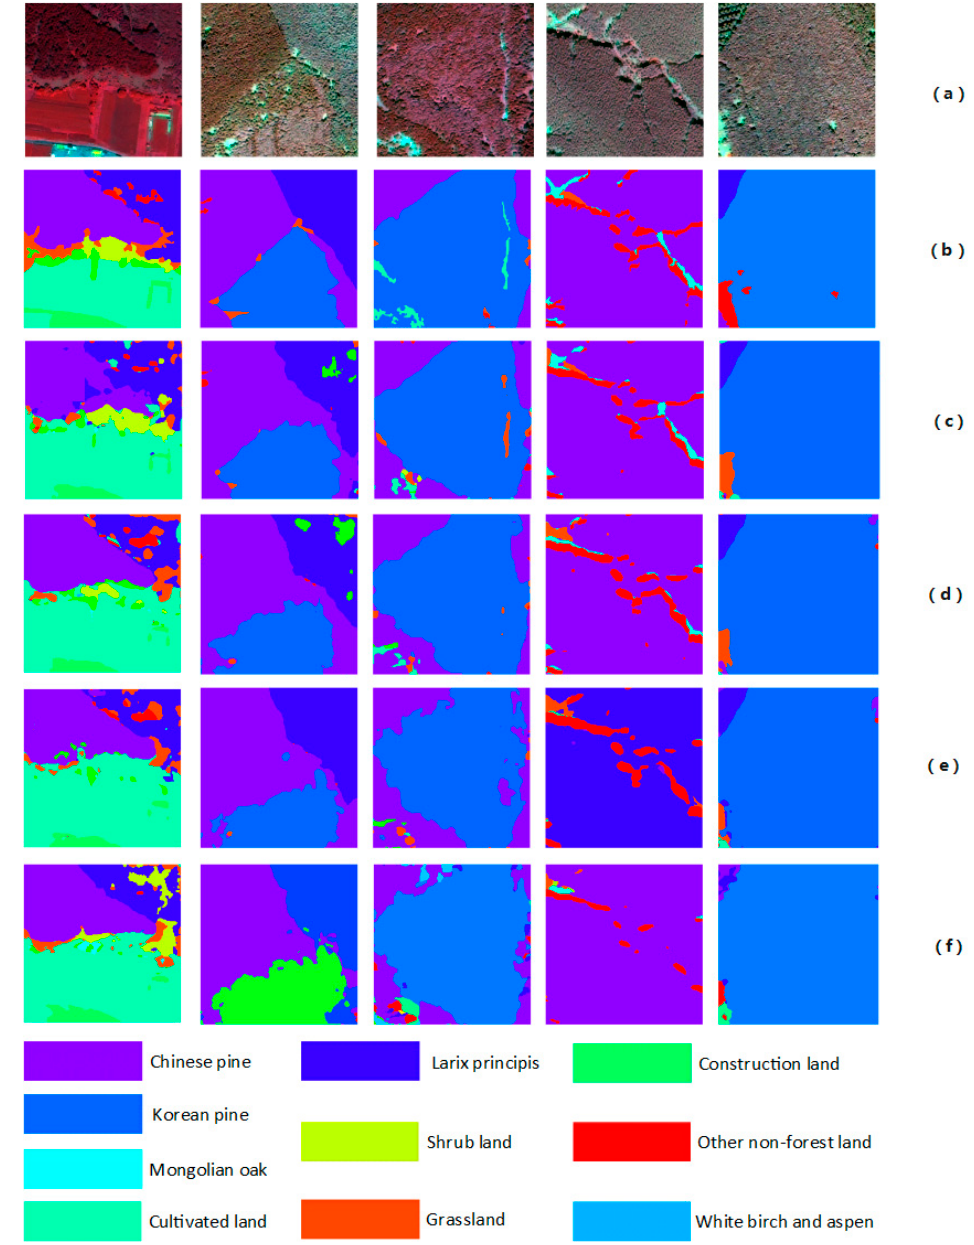
Figure 8. The detailed classification results of the four residual networks as encoder. ( a ) GF-2; ( b ) label; ( c ) Resnet 50; ( d ) Resnet 34; ( e ) Resnet 18; ( f ) Resnet 101. Table 6. Impact of the different fusion strategy of the decoder on classification accuracy. Dual-uNet-Resnet